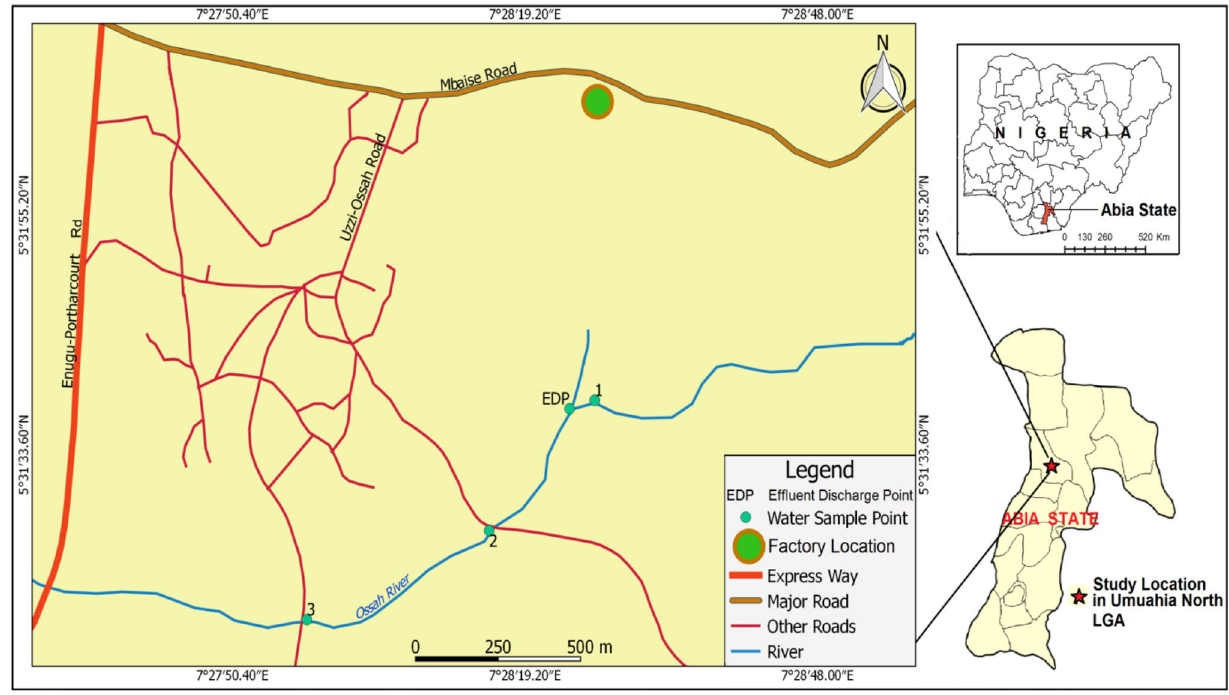
Fig. 1 Map of Umuahia, Abia State, Nigeria, showing the sampling stations of Ossah